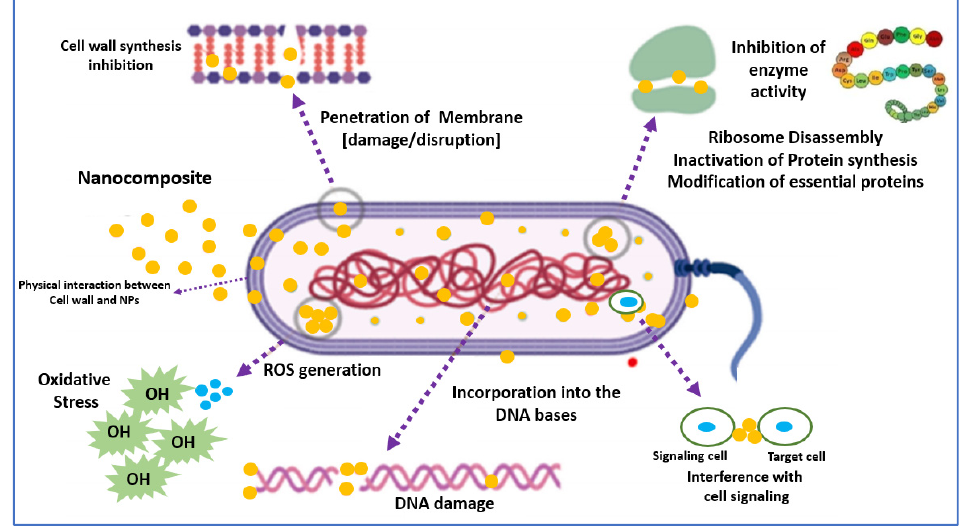
Figure 5. Schematic illustration of possible mechanisms of antibacterial activities of nanomaterials [40,41].